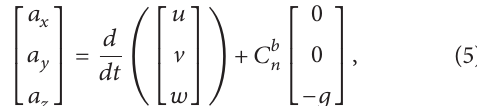
Figure 1: Diagram of the range